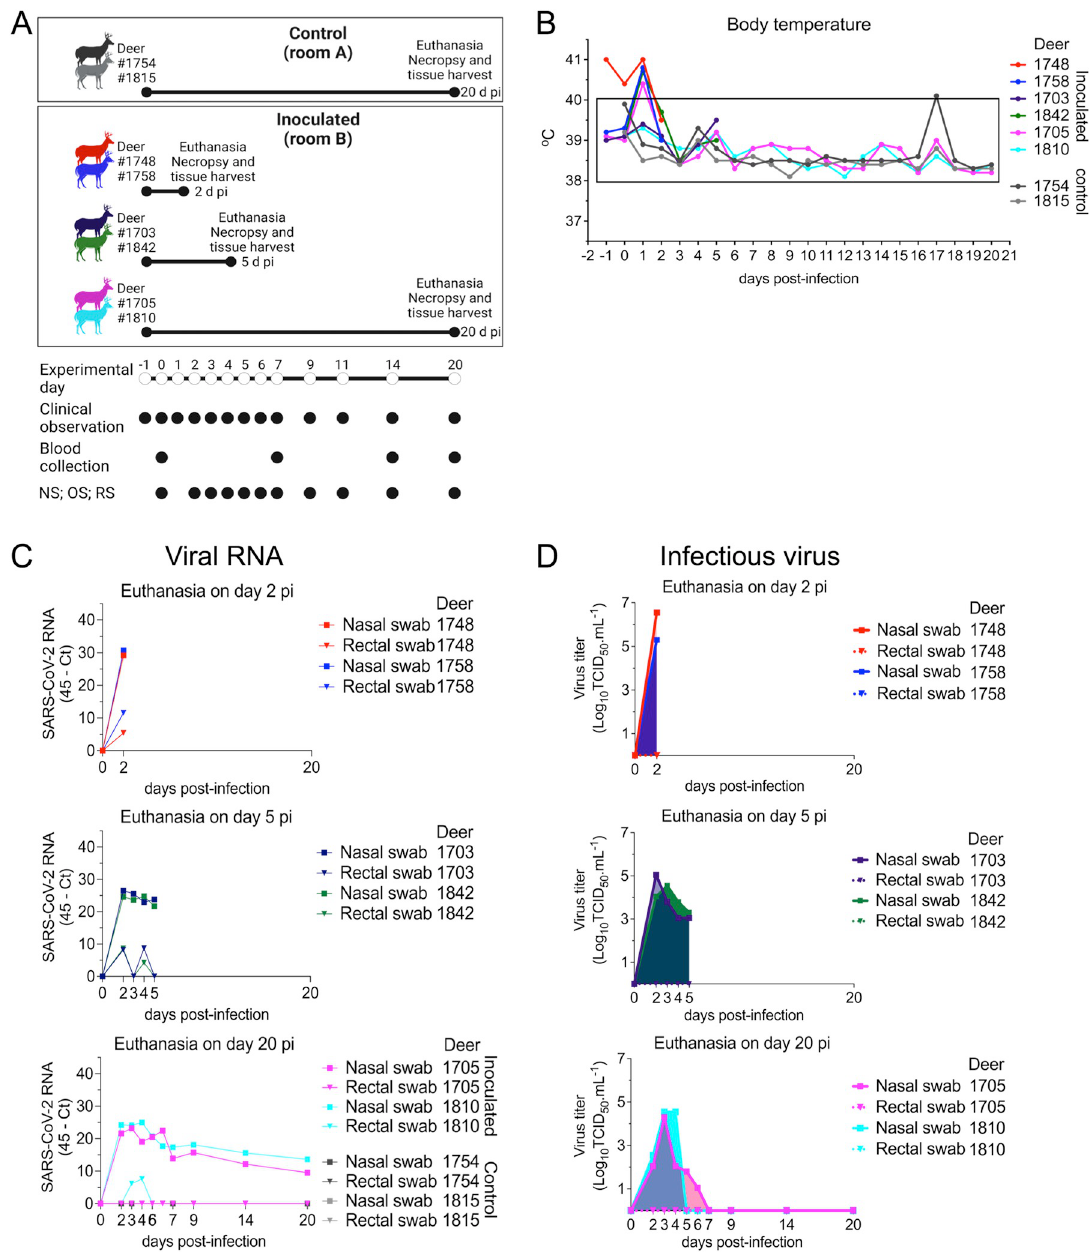
Fig 5. Pathogenesis and tissue tropism of SARS-CoV-2 in white-tailed deer. A ) Schematic representation of the pathogenesis study design. Adult deer were kept in two rooms of a biosafety level 3 (agriculture) (BSL-3Ag) facility. Two deer were maintained as control (uninoculated) in a separate rom (room A), and six deer were inoculated intranasally with 5 x 10 6.38 TCID 50 of SARS-CoV-2 isolate NYI67-20 (lineage B1) and housed in room B. To assess viral tissue tropism, two deer were euthanized on day 2 post-inoculation (pi) (animals no.1748 and 1758), two on day 5 pi (animals no. 1703 and 1842), and two inoculated (animals no. 1705 and 1810) and two control (animals no. 1754 and 1815) deer were euthanized on day 20 pi. B ) Inoculated and control deer were microchipped subcutaneously for temperature monitoring. Temperature and clinical signs were monitored daily starting on day 1 before inoculation until day 20 pi or until euthanasia. Body temperatures are expressed in degrees Celsius. C-E ) SARS-CoV-2 RNA load assessed in respiratory secretions and feces by real-time reverse transcriptase PCR (rRT-PCR) in deer until days 2 ( C ), 5 ( D ), or 20 pi ( E ). F-H ) Infectious SARS-CoV-2 assessed in respiratory secretions and feces assessed by virus titration in rRT-PCR-positive samples until days 2 ( F ), 5 ( G ), or 20 pi ( H ). Virus titers were determined using end point dilutions and expressed as TCID 50 .ml -1 . All control deer (uninoculated) remained negative throughout the experimental period.